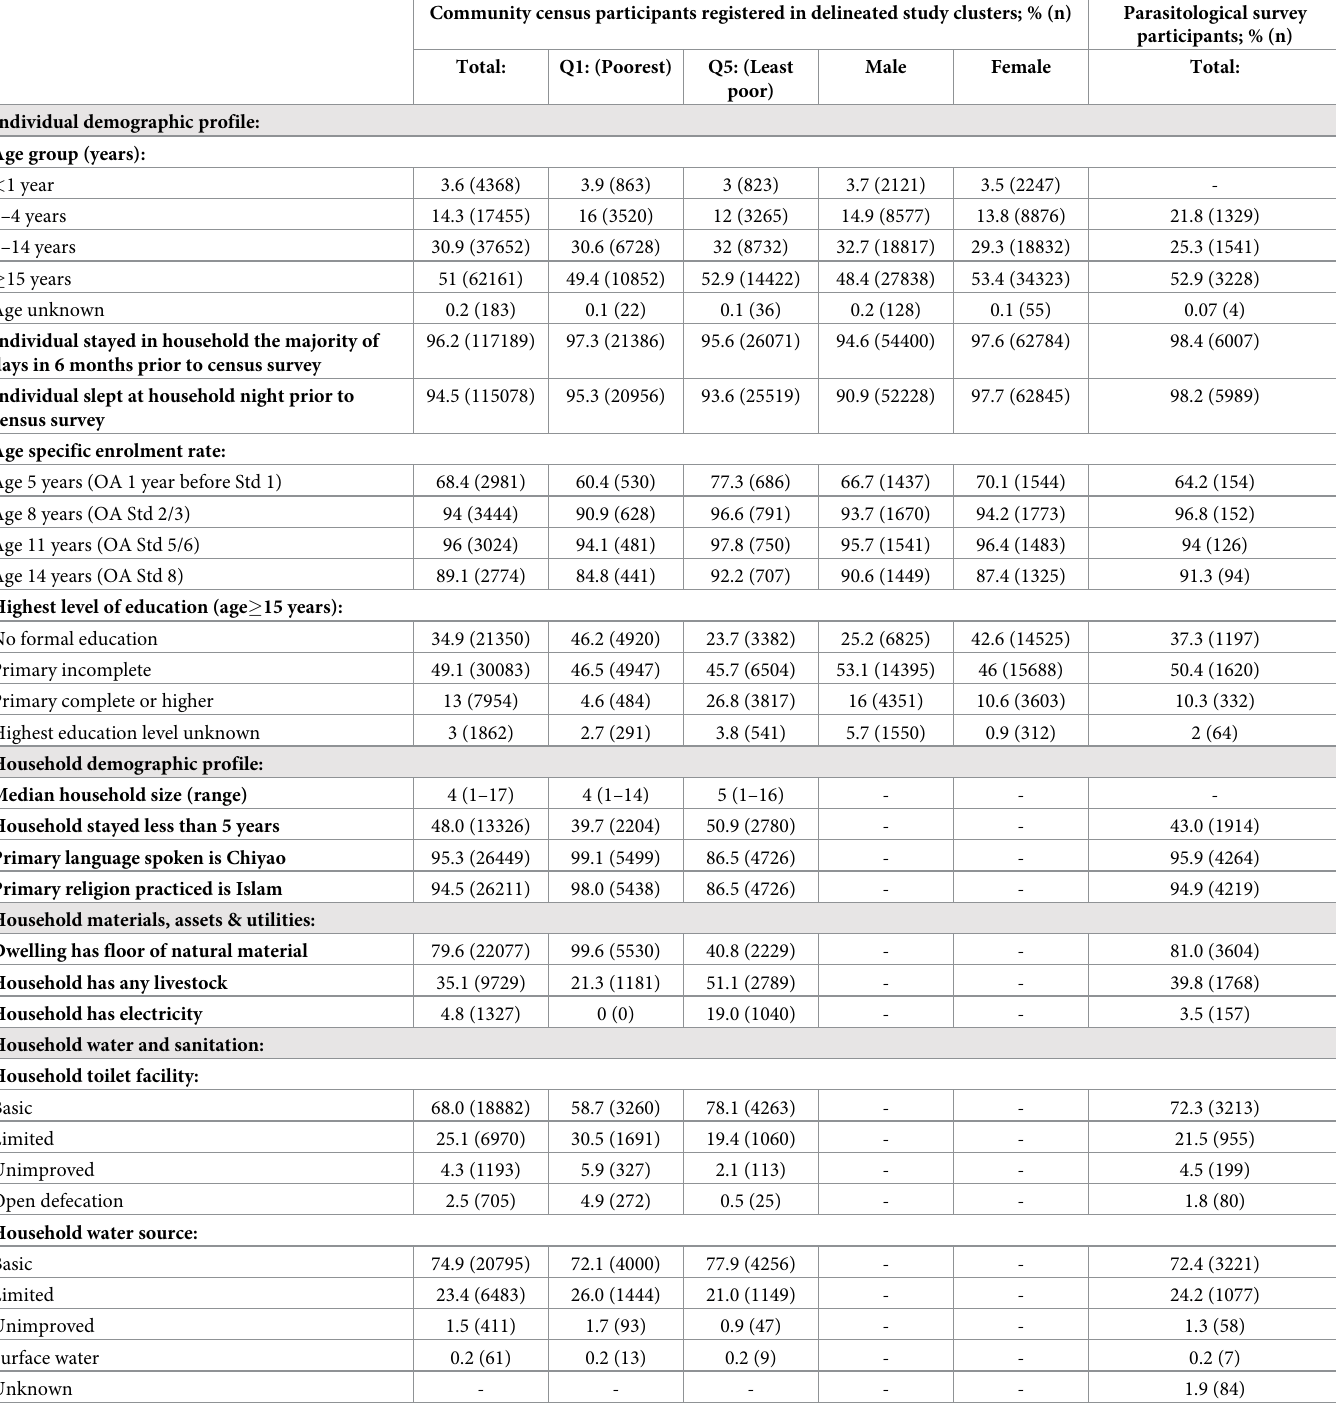
Table 1. Individual and household-level characteristics of (i) community census participants registered in delineated study clusters in total, disaggregated by socio- economic status, and disaggregated by sex; and (ii) parasitological survey participants in total; in Namwera, Mangochi district, Malawi in 2018. Community census participants registered in delineated study clusters; %